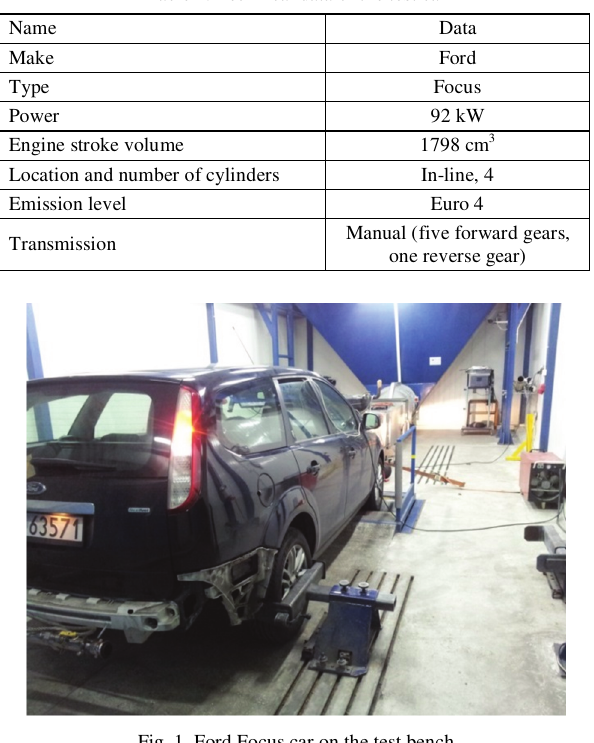
Table 1. Technical data of the test car